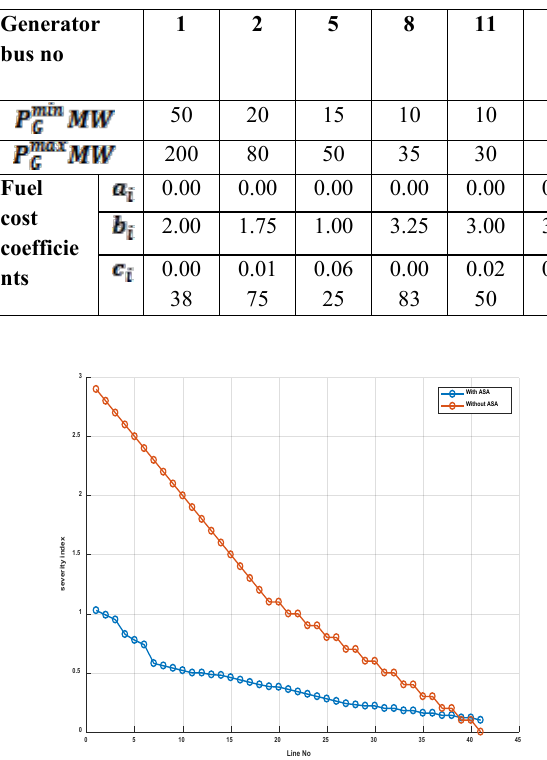
Figure 6. Analysis of voltage